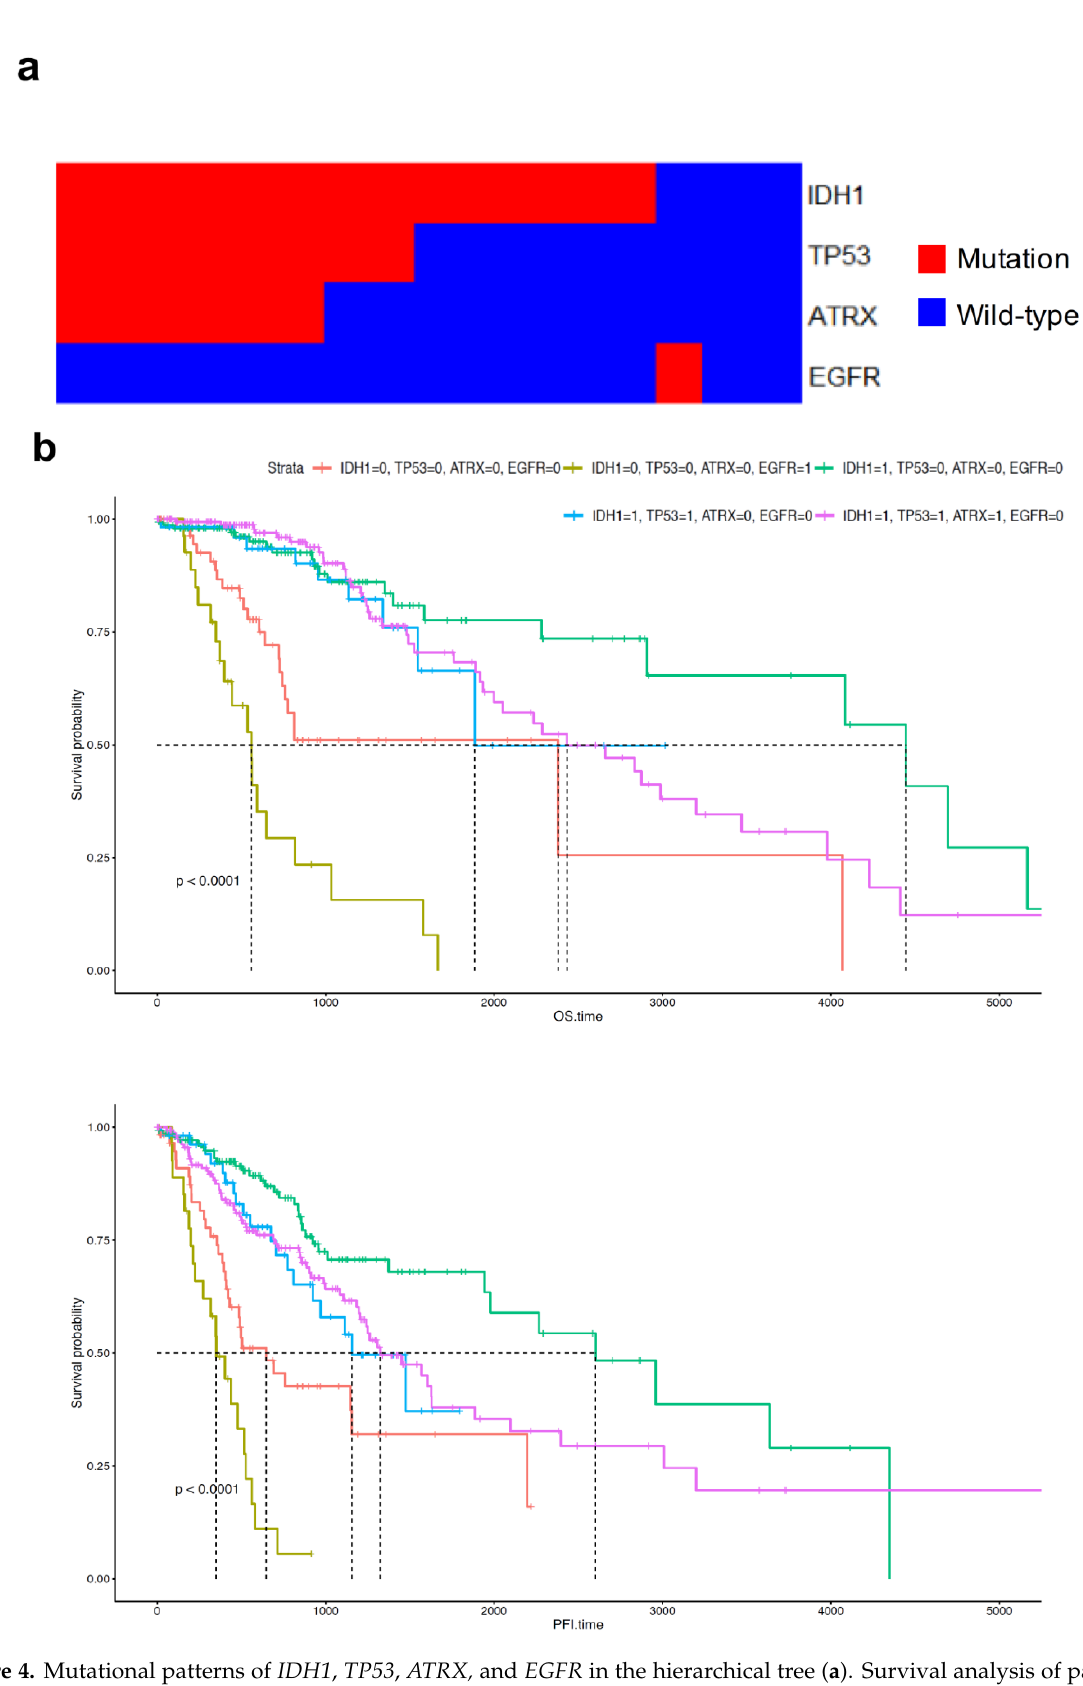
Figure 4. Mutational patterns of IDH1 , TP53 , ATRX, and EGFR in the hierarchical tree ( a ). Survival analysis of patients with mutant or wild-type genes in terms of overall survival and progression-free survival ( b ). 0 indicates wild-type; 1 indicates mutation.